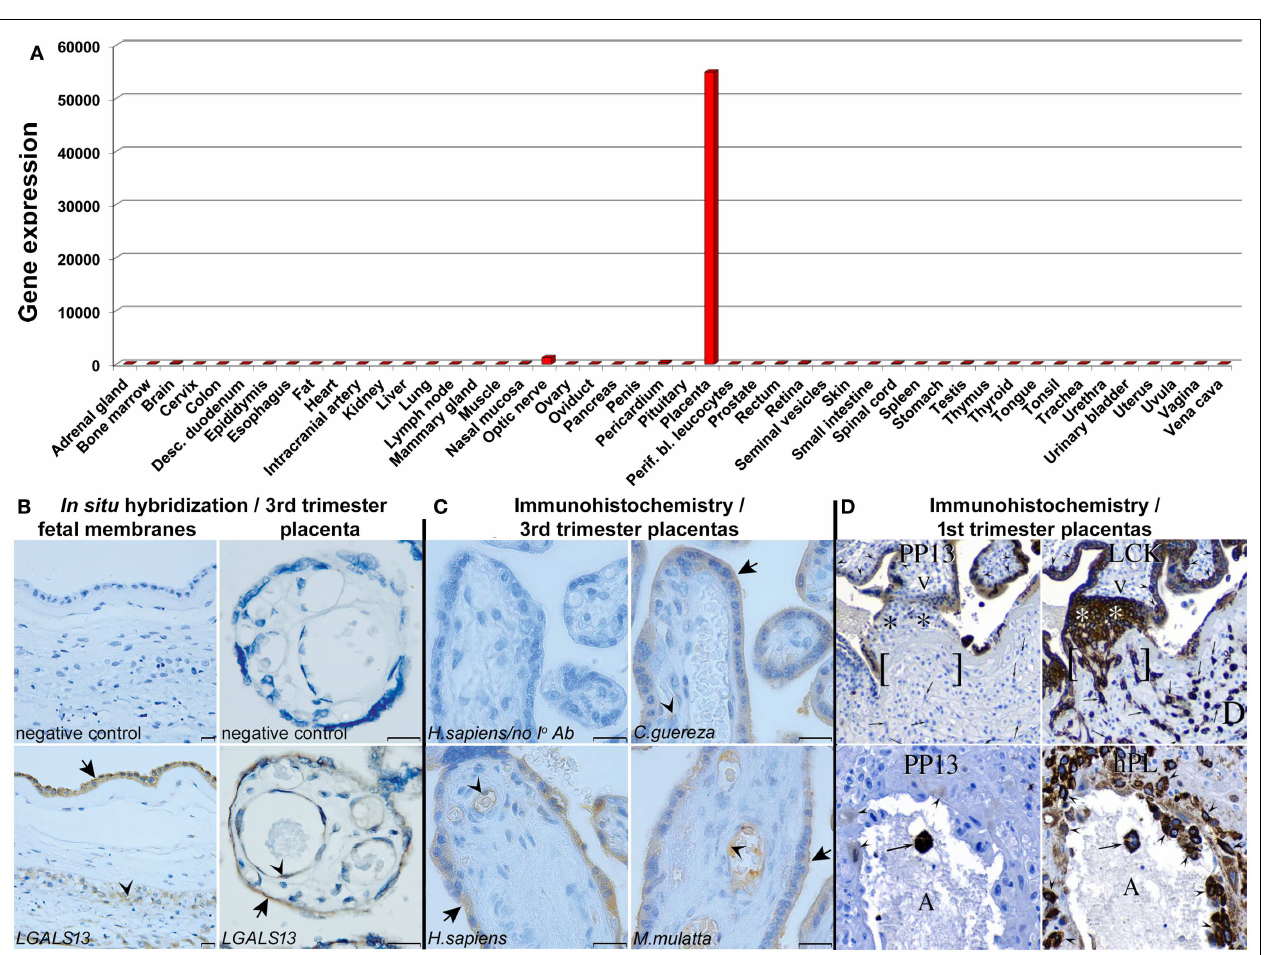
and decidual cells were negative. PP13 immunostaining was found in the syncytiotrophoblast.The cytotrophoblasts (arrowheads), anchoring trophoblasts (*), early infiltrating trophoblasts [ ], and the invasive trophoblasts (arrows) in the decidua (D) were negative. (Lower panel) Serial sections of 8week maternal spiral arterioles immunostained for PP13 and human placental lactogen (hPL). All the decidual invasive, intravascular and endovascular trophoblasts (arrowheads), and a single luminal (A) syncytiotrophoblast (arrow) were stained for hPL.The monoclonal anti-PP13 antibody did not stain decidual invasive trophoblasts, lightly stained endovascular trophoblasts (arrowheads), and it intensely stained luminal syncytiotrophoblasts (arrow). Figure (A) represents data published in Ref. (23). Figures (B,C) were published in Ref. (23). Figure (D) was published in Ref. (8). Kind permission for the reuse of the figures was obtained from the National Academy of Sciences of the United States of America (A-C) and SAGE US (D)